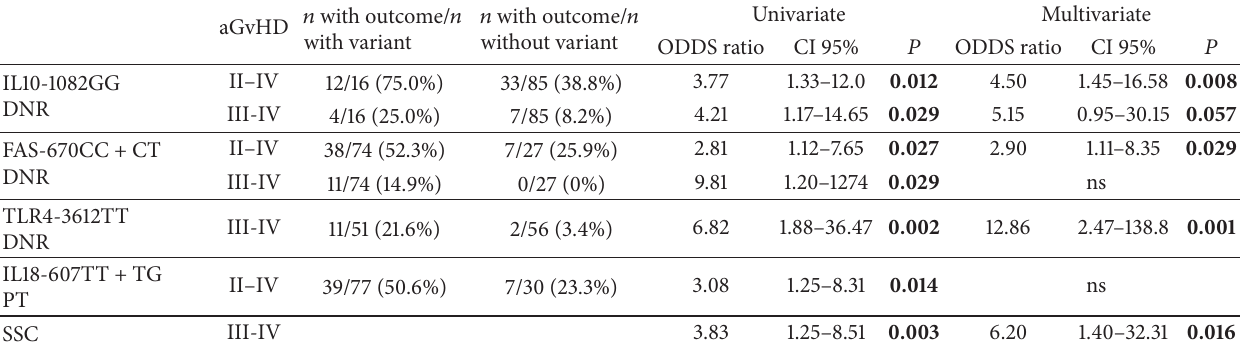
Table 2: Univariate and multivariate analysis of the variables significantly associated with severe GvHD. 𝑛 with outcome/ 𝑛 𝑛 with outcome/ 𝑛 Univariate Multivariate aGvHD with variant without variant ODDS ratio CI 95% 𝑃 ODDS ratio IL10-1082GG II–IV 12/16